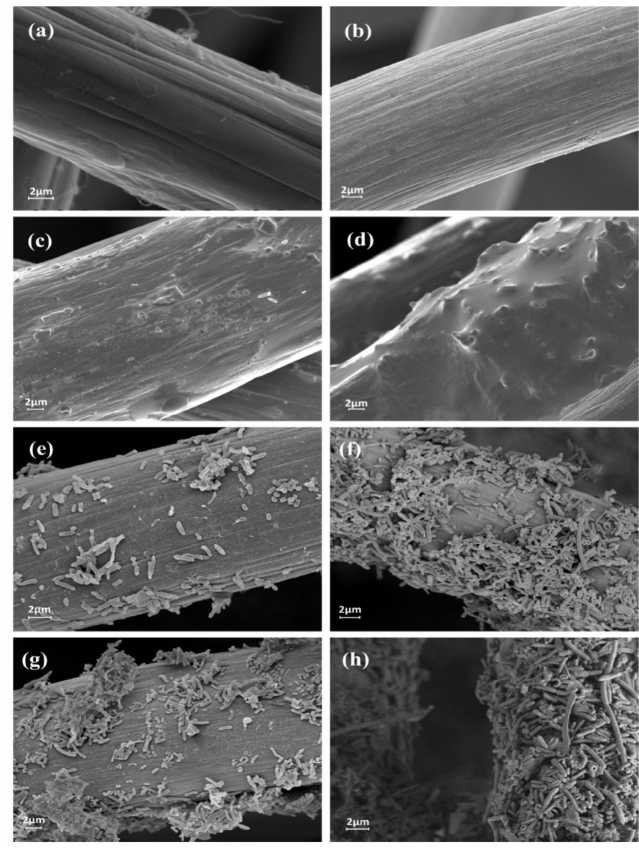
Figure 5. SEM images of the fresh ( a ) GF, ( b ) AGF, ( c ) PHQ–GF, ( d ) PHQ–AGF samples, and the ( e )